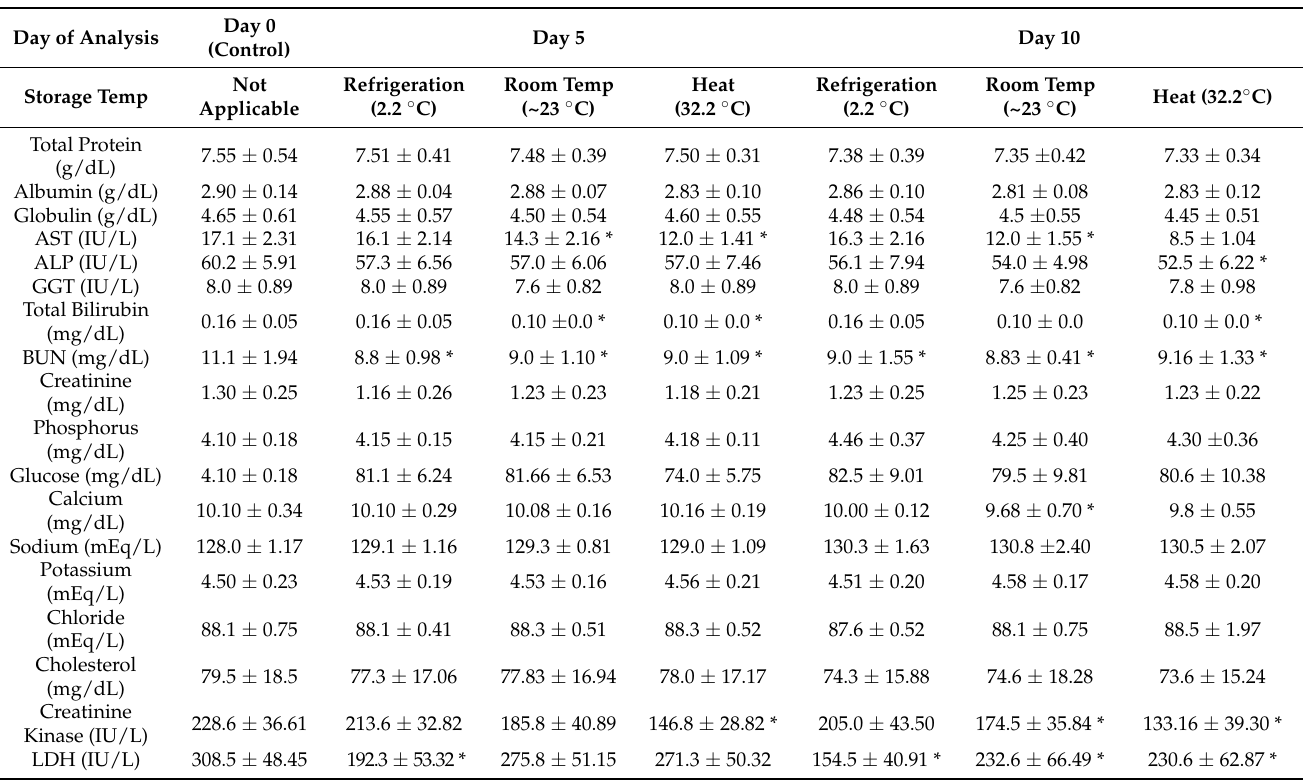
Table 1. Biochemical values of African savanna elephants (Loxodonta africana) under different storage lengths and